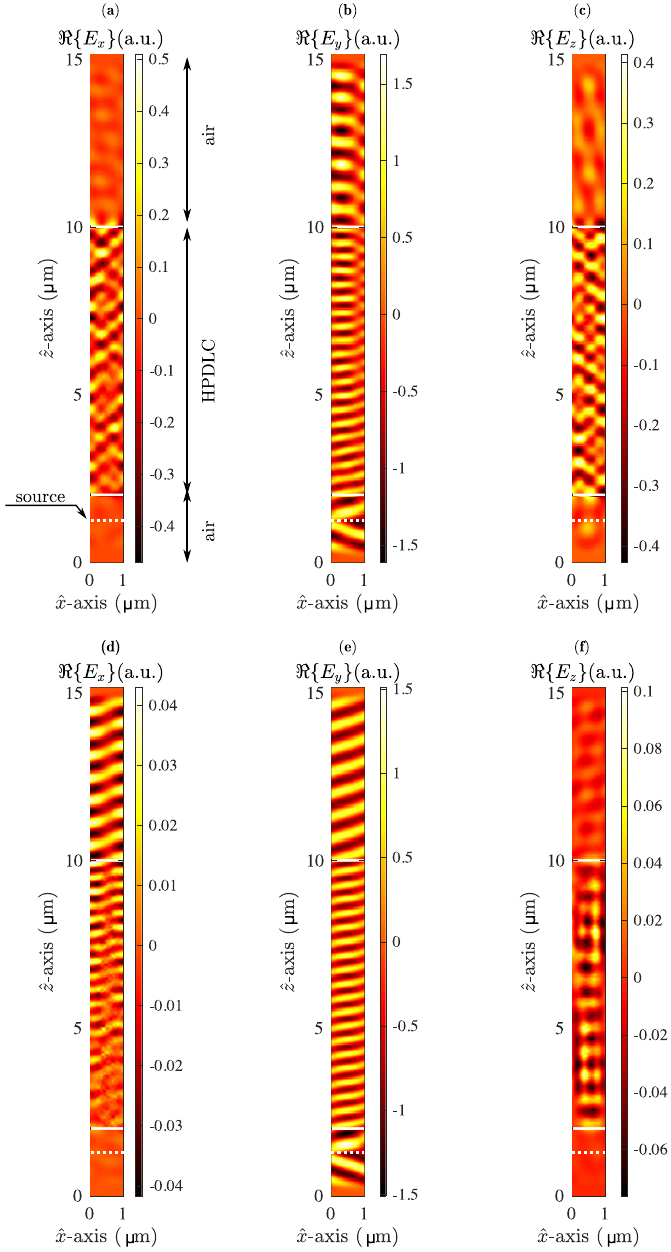
Figure 4. Representation of the xz plane slice of (cid:60){ E i } , with i = x , y and z . In all cases y = 0.49 µ m and W 0 = 10 − 5 J/m 2 . ( a ), ( b ) and ( c ) show the x , y and z components of the electrical field for Φ = 0 V, respectively. ( d ), ( e ) and ( f ) show the x , y and z components of the electrical field for Φ = 200 V,